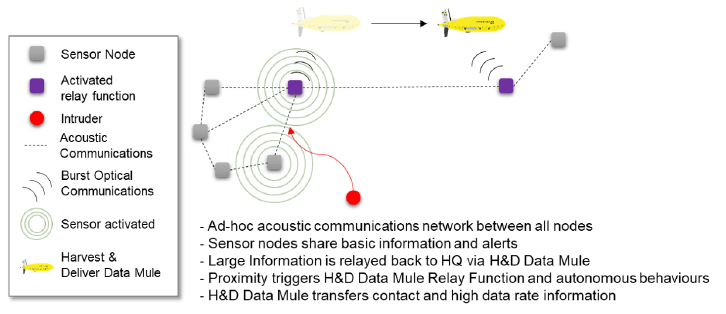
Figure 6. Concept of autonomous harvest and deliver data